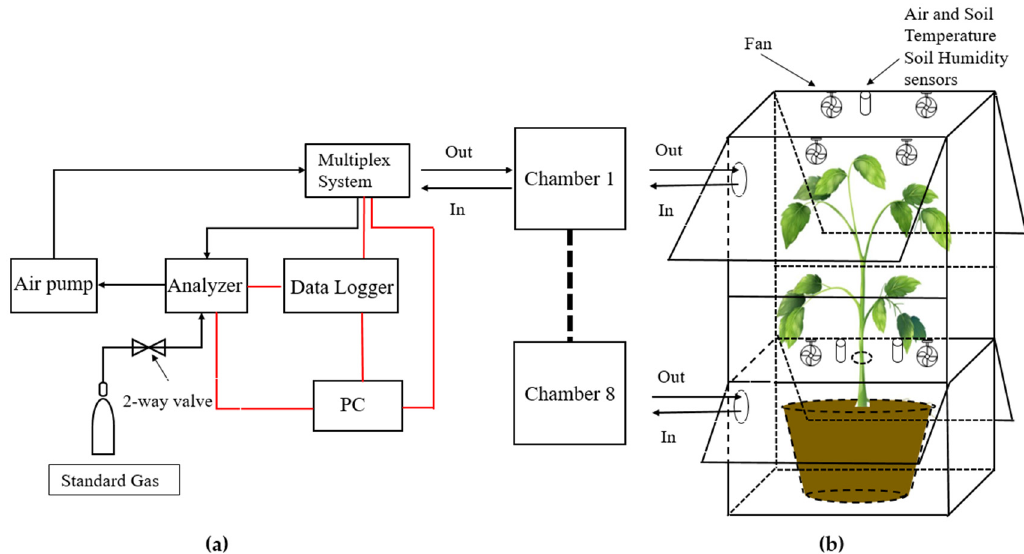
Figure 1. Schematic diagram of the observation process of CO 2 /H 2 O exchange in sapling crown by chamber method. ( a ) Schematic overview of the automated multichannel gas-exchange measuring chamber system. Air in the closed chamber passed through the multiplex system air inlet port, analyzer, pump, and the multiplex system air outlet port and then returned to the chamber. The connecting cables are depicted in red lines; ( b ) schematic drawing of the chamber, showing the opening windows and other assistive